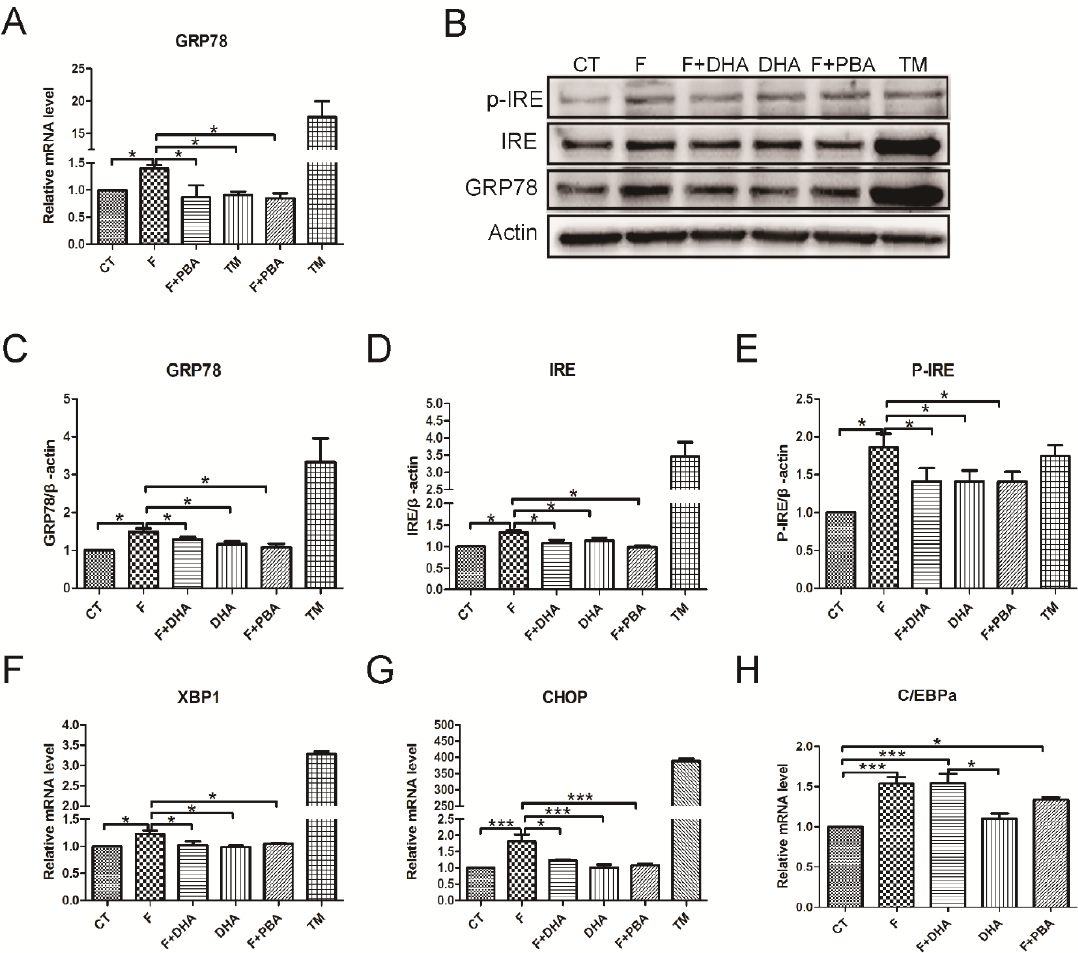
Figure 5. DHA alleviated fructose-induced ER stress response in primary mouse hepatocytes. CT: